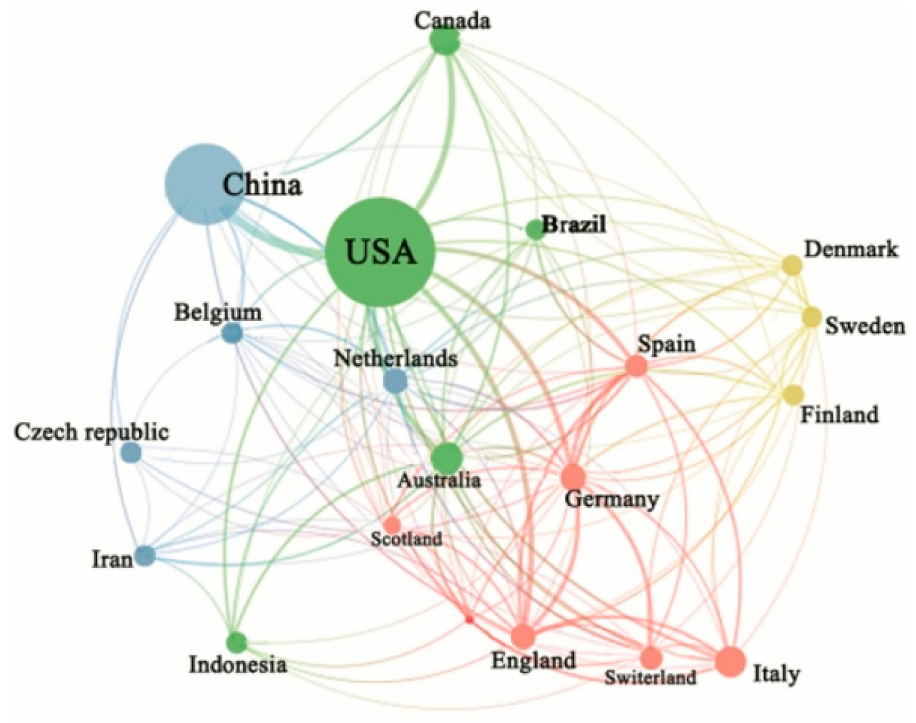
Figure 7. Collaboration map of the most-producing countries in the field of land use